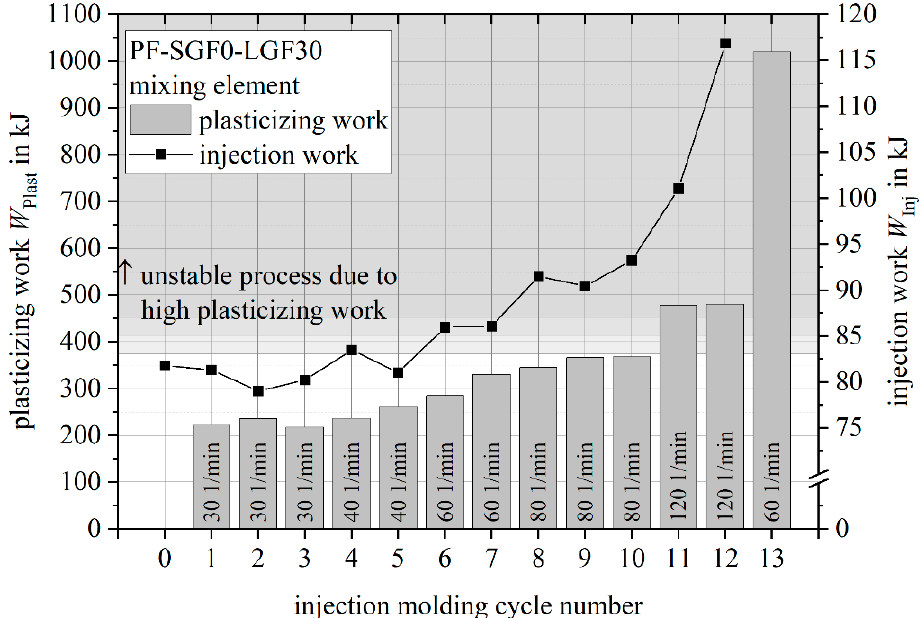
Figure 8. Plasticizing work and injection work for PF-SGF0-LGF30 screw speed study (usage and extension of the results presented in [57]).